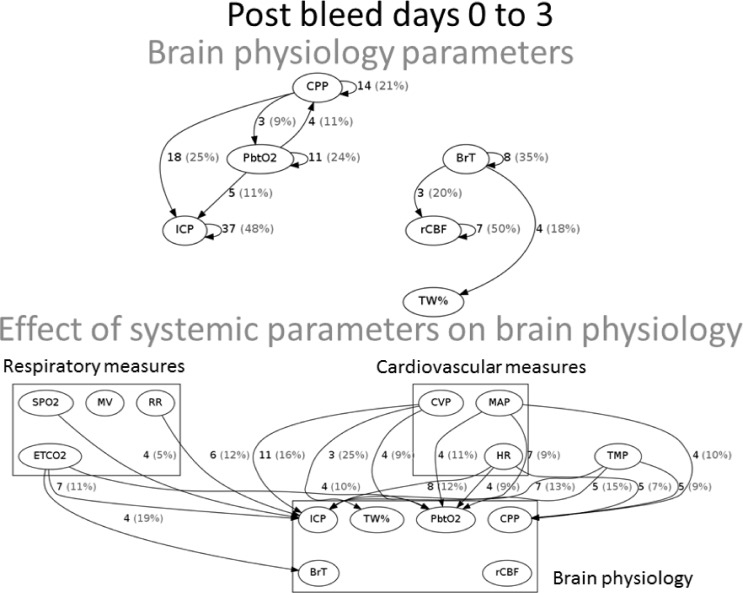
Brain physiology phase 1: Relationships within brain monitoring parameters (top row) and with systemic parameters (bottom row).